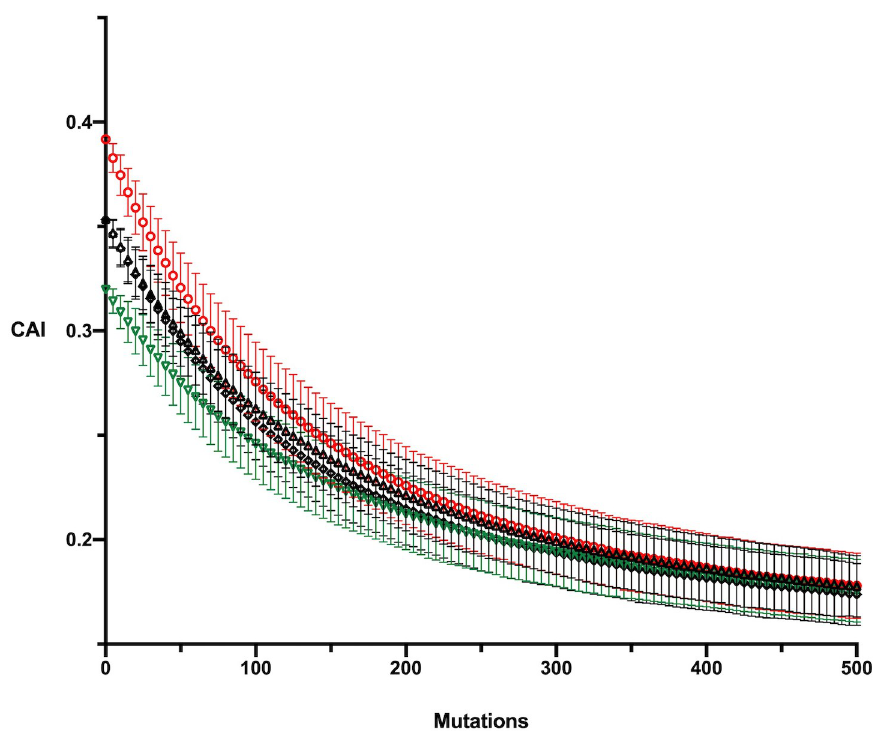
Fig 2. Simulation results for the MC2020 model with synonymous substitutions only for the four reconstructed ancestral sequences of psbA ; MP-High (red), MP-Low (green) and ML-AA and ML-DNA (both black).